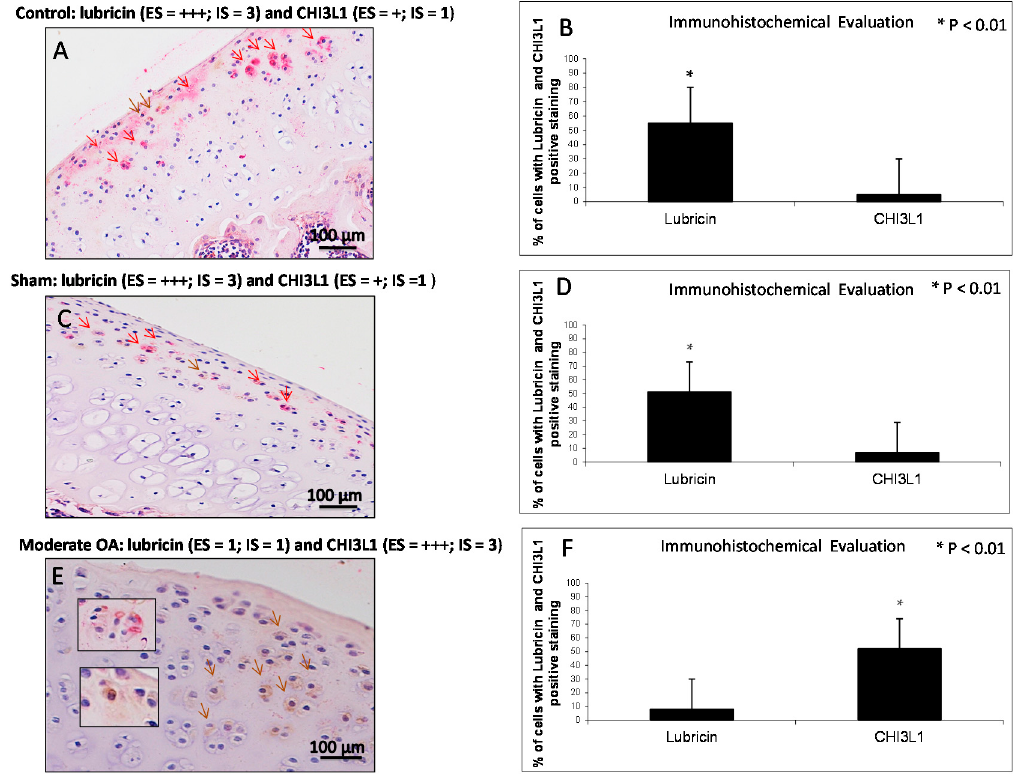
Figure 5. Evaluation of lubricin and CHI3L1 double staining in control and in moderate OA cartilage. ( A , C ) In control and in sham groups lubricin immunolabeling was strong (ES = +++; IS = 3, red staining, red arrows), instead the expression of CHI3L1 was weak/absent (ES = +; IS = 1, brown staining, brown arrow); ( E ) In moderate OA, lubricin immunolabeling was weak/absent (ES = +; IS = 1, red staining, red arrows), instead the expression of CHI3L1 was strong (ES = +++; IS = 3, brown staining, brown arrows); ( A , C , E ) Magnifications ×20; Scale bars: 100 µm; inserts: magnifications ×40; Scale bars: 50 µm; ( B ) Immunohistochemical evaluation graph: percentage of lubricin and CHI3L1-positive cells out of the total number of cells counted in the control group; ( D ) Immunohistochemical evaluation graph: percentage of lubricin and CHI3L1-positive cells out of the total number of cells counted in the sham group; ( F ) Immunohistochemical evaluation graph: percentage of lubricin and CHI3L1-positive cells out of the total number of cells counted in the moderate OA group. Results are presented as the mean ± SEM. Student’s t test, was used to evaluate the significance of the results. * p < 0.01, when compared lubricin vs. CHI3L1.